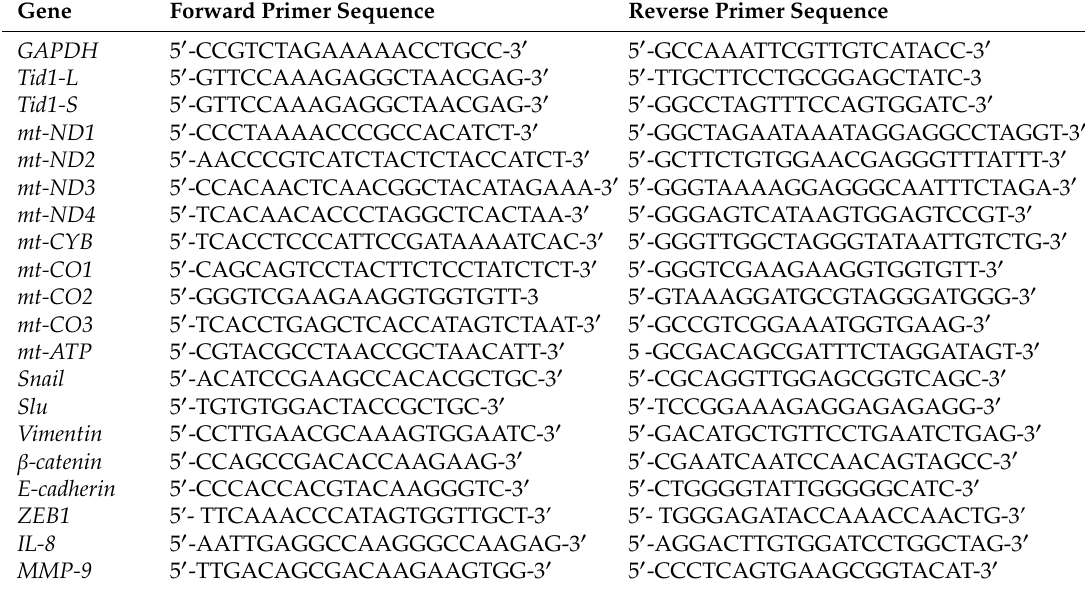
Table 2. The real-time PCR primers